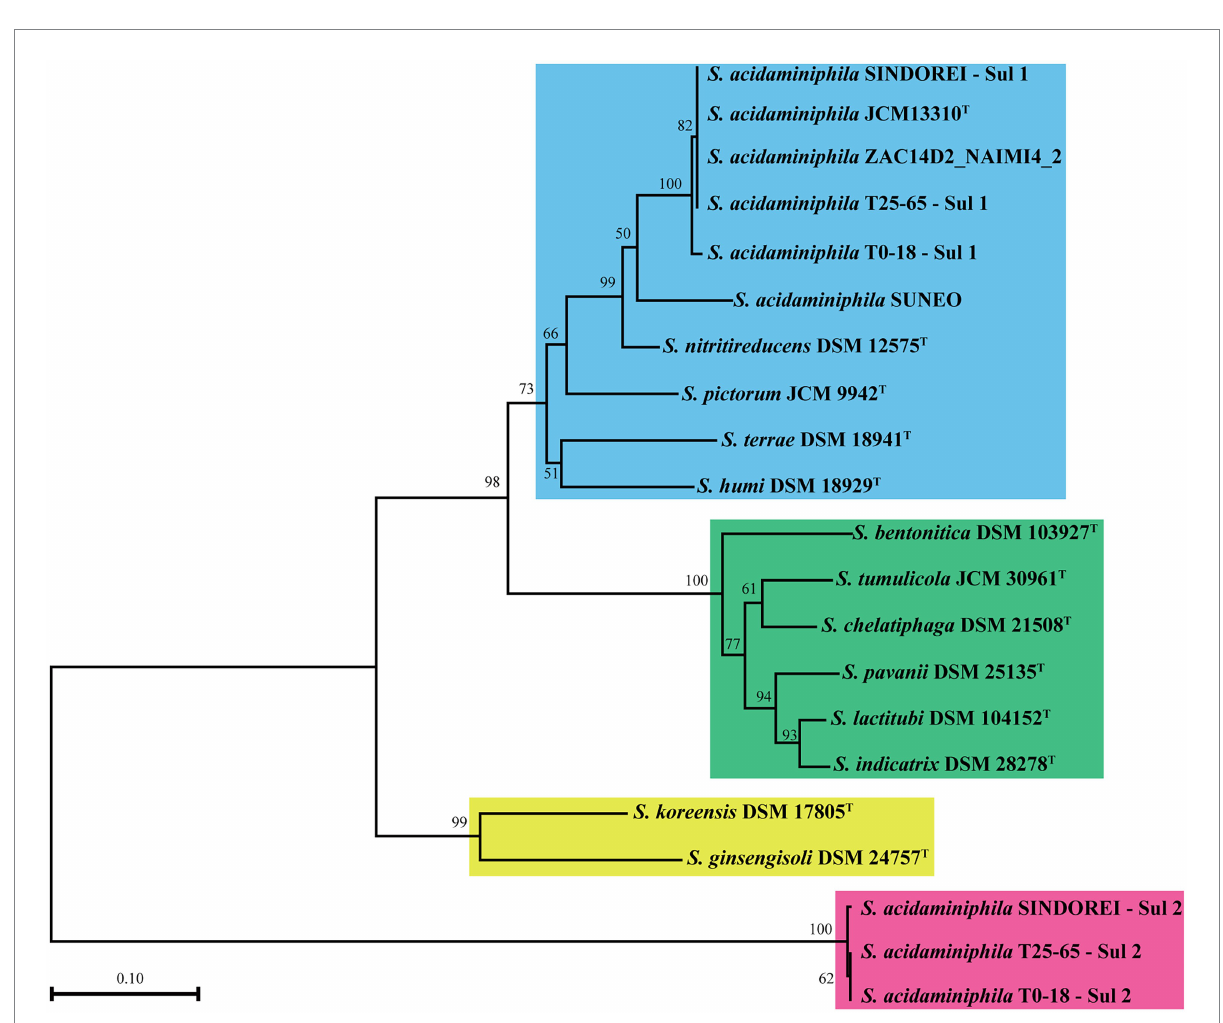
FIGURE 7 The phylogenetic tree based on the amino acid of sul genes in the members of genus Stenotrophomonas . The numbers present on the branches of the tree represent the bootstrap values (based on 1,000